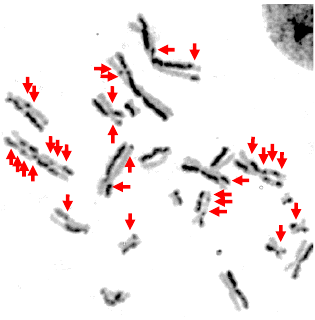
Figure 3. Representative image of sister chromatid exchange (SCE) after NB-UVB 500 J/m 2 : Red arrows indicate sister chromatid exchanges.